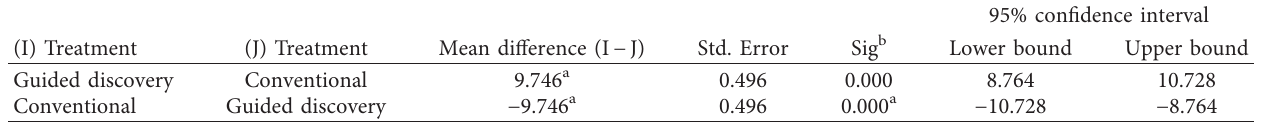
Table 7: Bonferroni’s analysis of retention test by treatment.